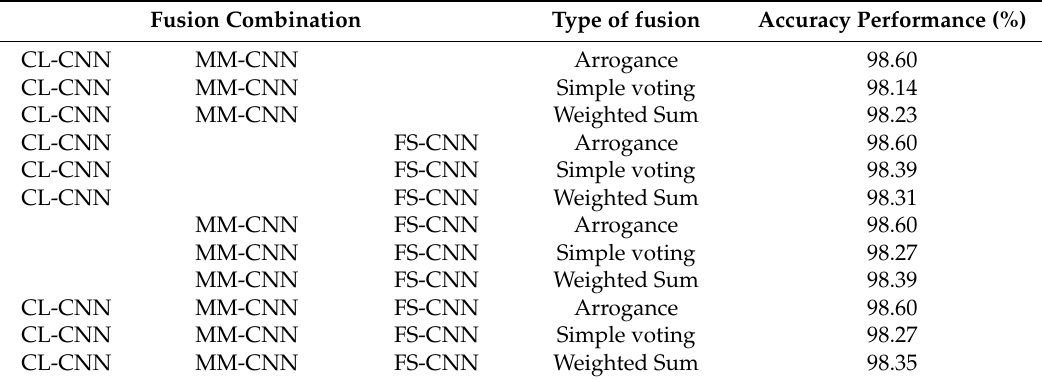
Table 8. Performance of fusing classifiers outputs from the second set of